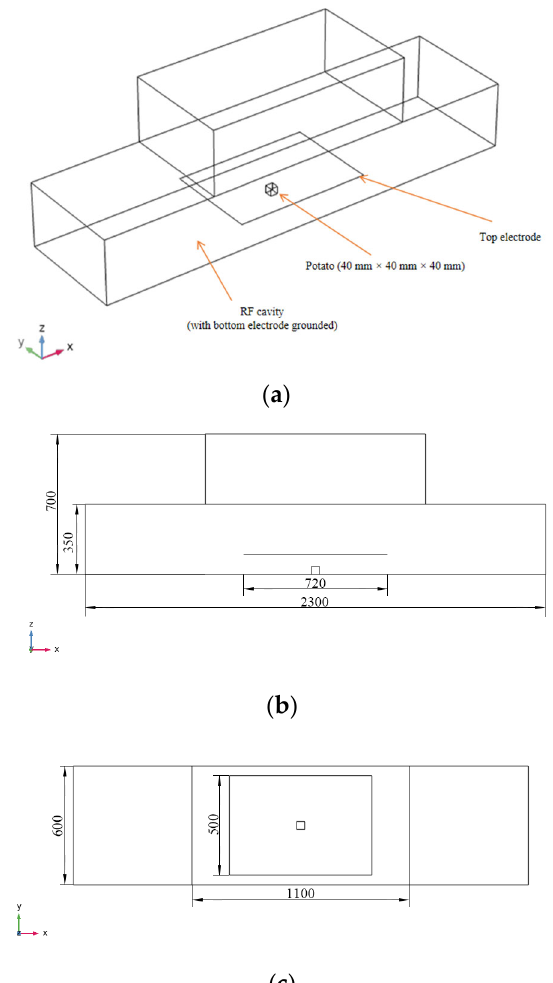
Figure 2. Geometric model of RF drying heater and placement of potato: ( a ) layout, ( b ) front view, and ( c ) top view (all dimensions are in mm).